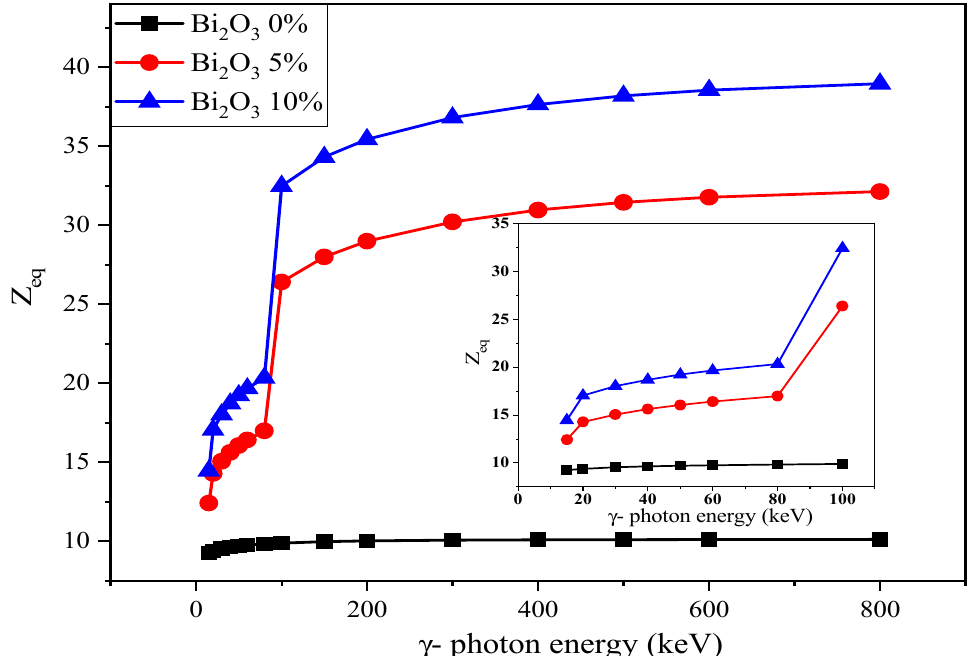
Figure 9. Variation in the equivalent atomic number (Z eq ) of the fabricated polyepoxide-reinforced Bi 2 O 3 composites versus the emitted γ -photon energy.